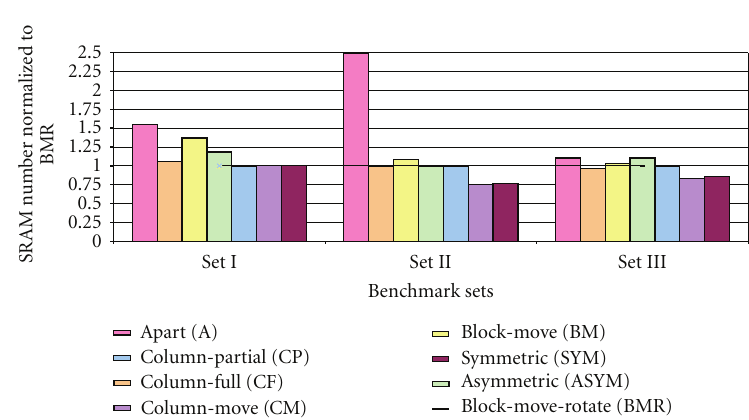
Figure 18: Generalized configuration memory results of mesh- and tree-based architectures.